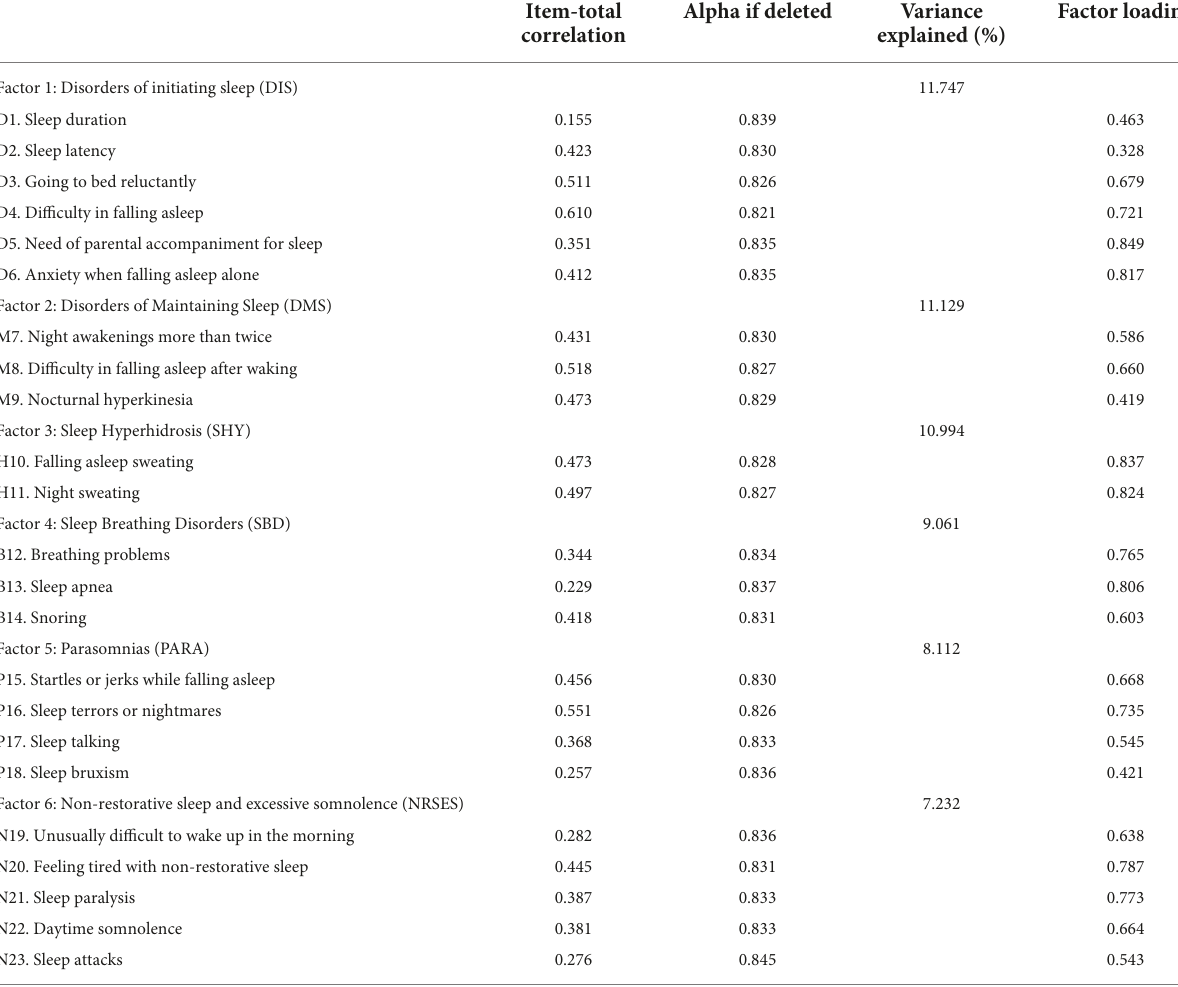
TABLE 4 Item-total correlation analysis and exploratory factor analysis of the SDSC-I ( n =